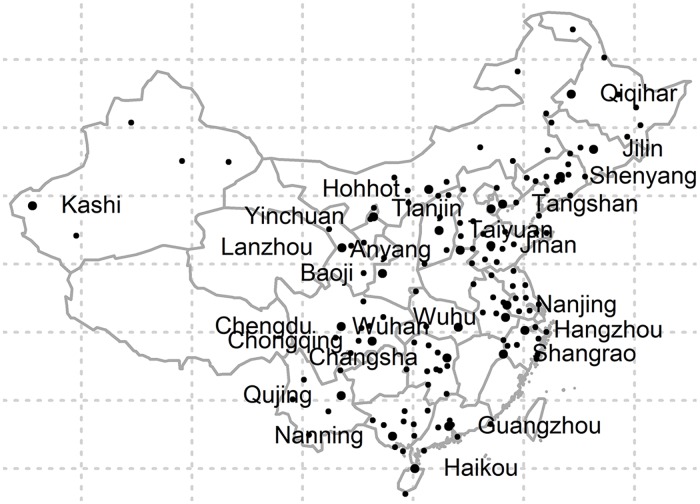
Locations of the 172 Chinese cities in this study.The most populous city in each province is marked with its name.